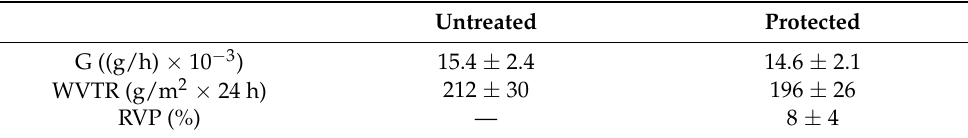
Figure 5. Curves of water absorption by capillarity before and after the PT 3 treatment.